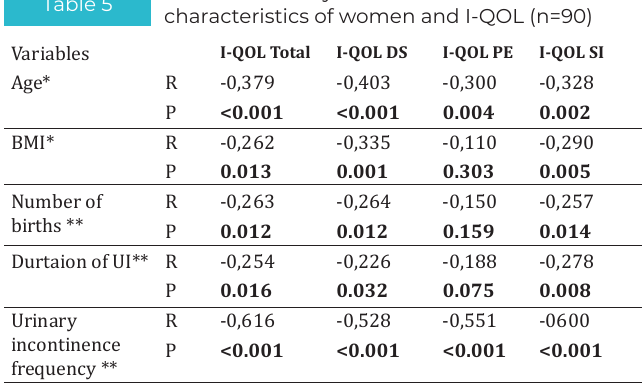
Correlation analysis between some characteristics of women and I-QOL (n=90)